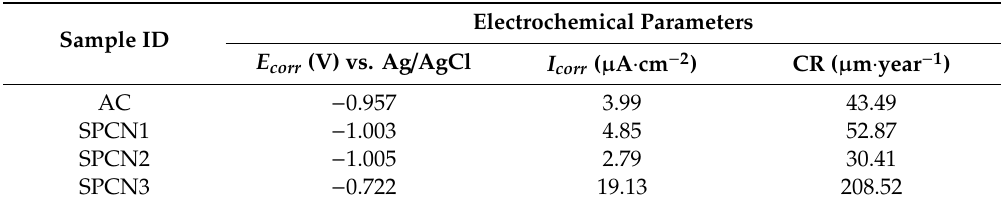
Table 4. Electrochemical parameters of coatings extracted after fitting of potentiodynamic plots in Tafel regions exposed to 3.5% NaCl